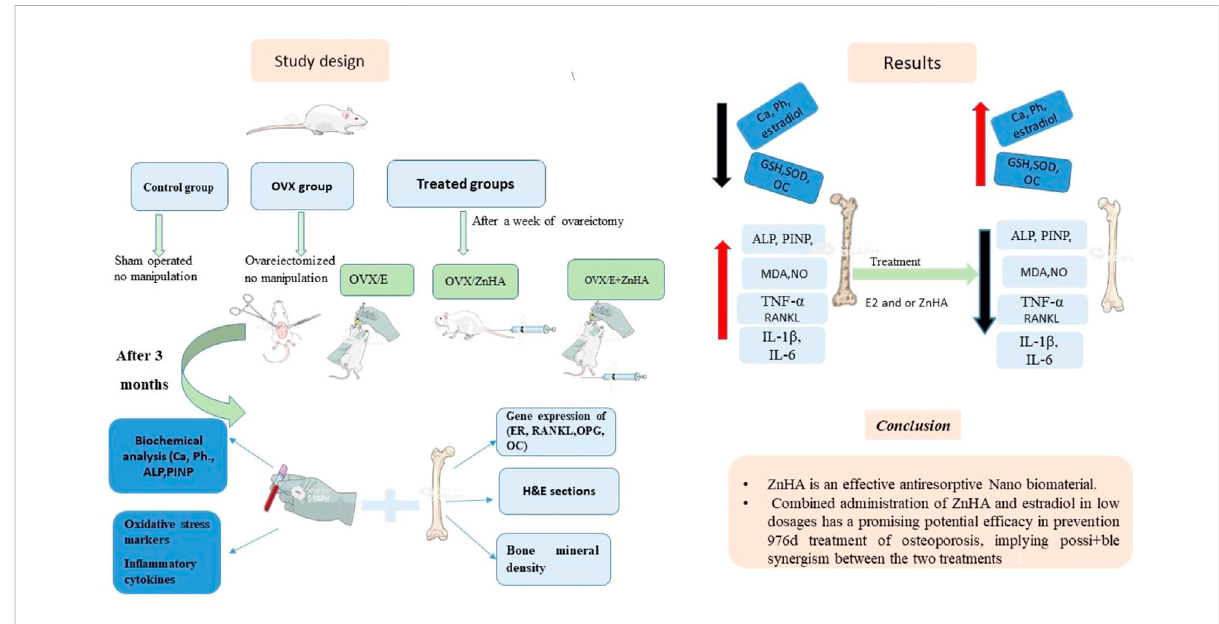
FIGURE 1 Summary of the